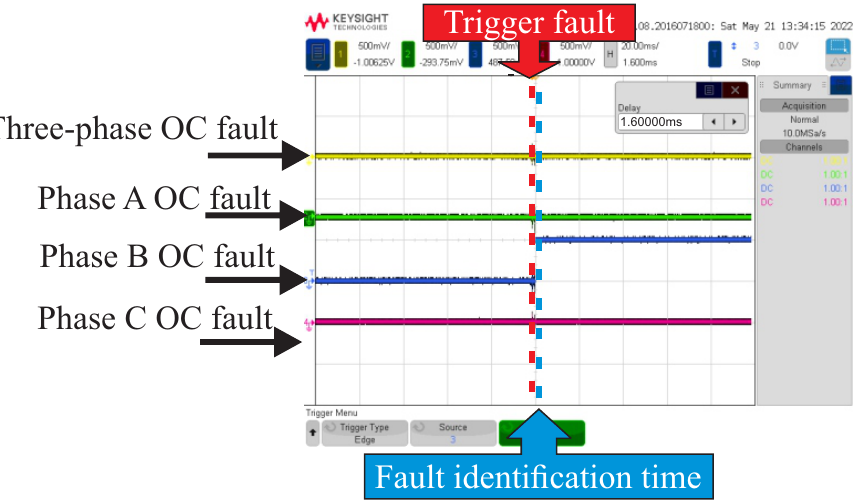
Figure 18. Single-phase open circuit fault identification with 4 × 4 SOM: Phase B; detection time 1.6 ms.